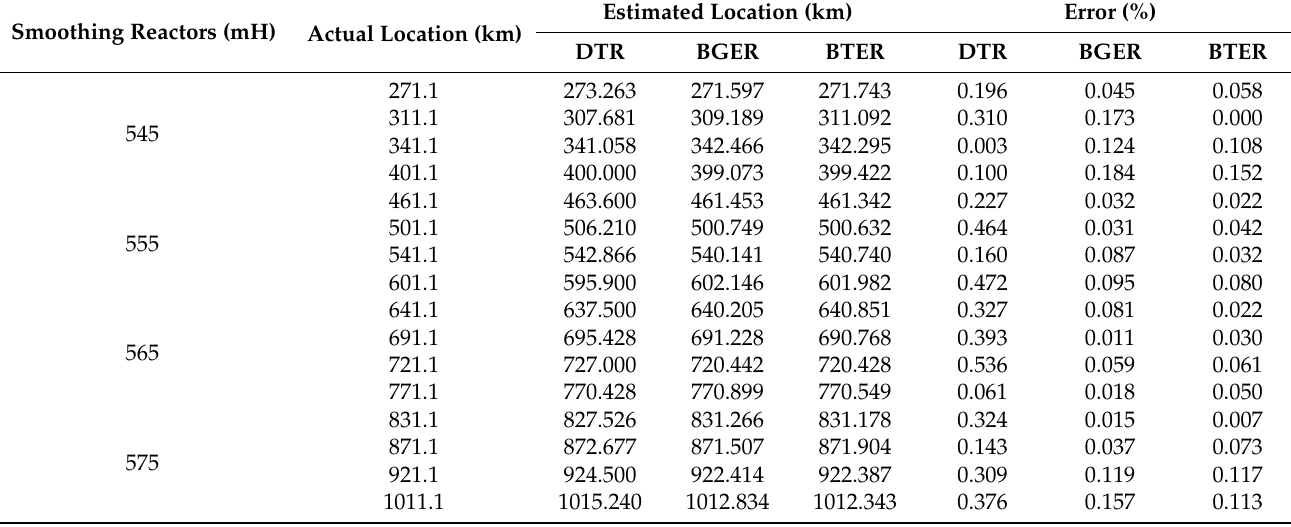
Table 4. Actual and estimated fault location varying smoothing